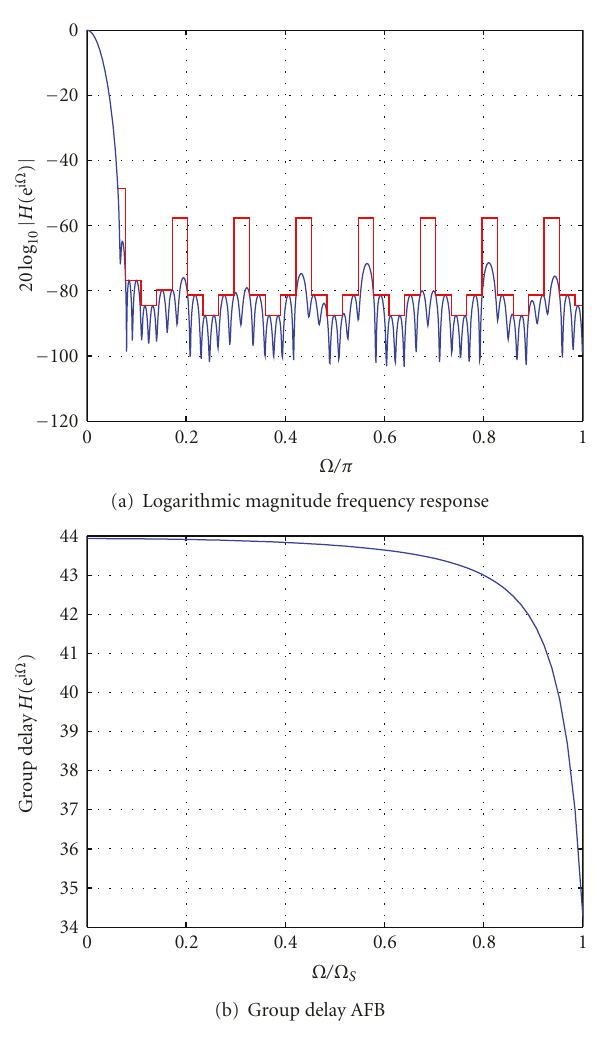
Figure 2: Narrow-band FIR low-pass